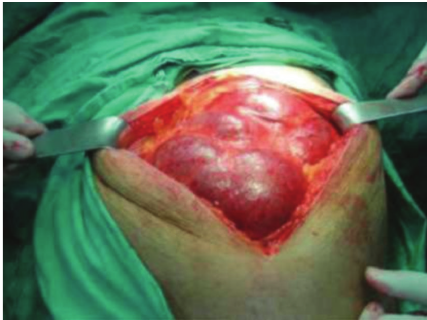
Figure 2: Intraabdominal appearance due to left pyonephrosis dur- ing surgery.